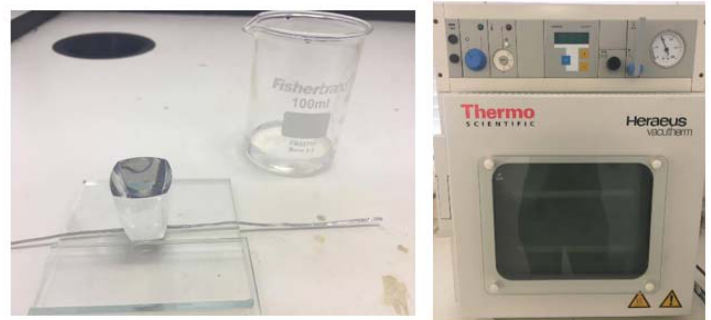
Figure 5. The RACPC ‐ photovoltaic (PV) cell on the glass substrate and the Sylgard ‐ 184 ® solution in a Figure 5. The RACPC-photovoltaic (PV) cell on the glass substrate and the Sylgard-184 ® solution in a beaker (left), and the Heraeus Vacutherm™ vacuum chamber to eliminate the air bubble (right). beaker (left), and the Heraeus Vacutherm ™ vacuum chamber to eliminate the air bubble